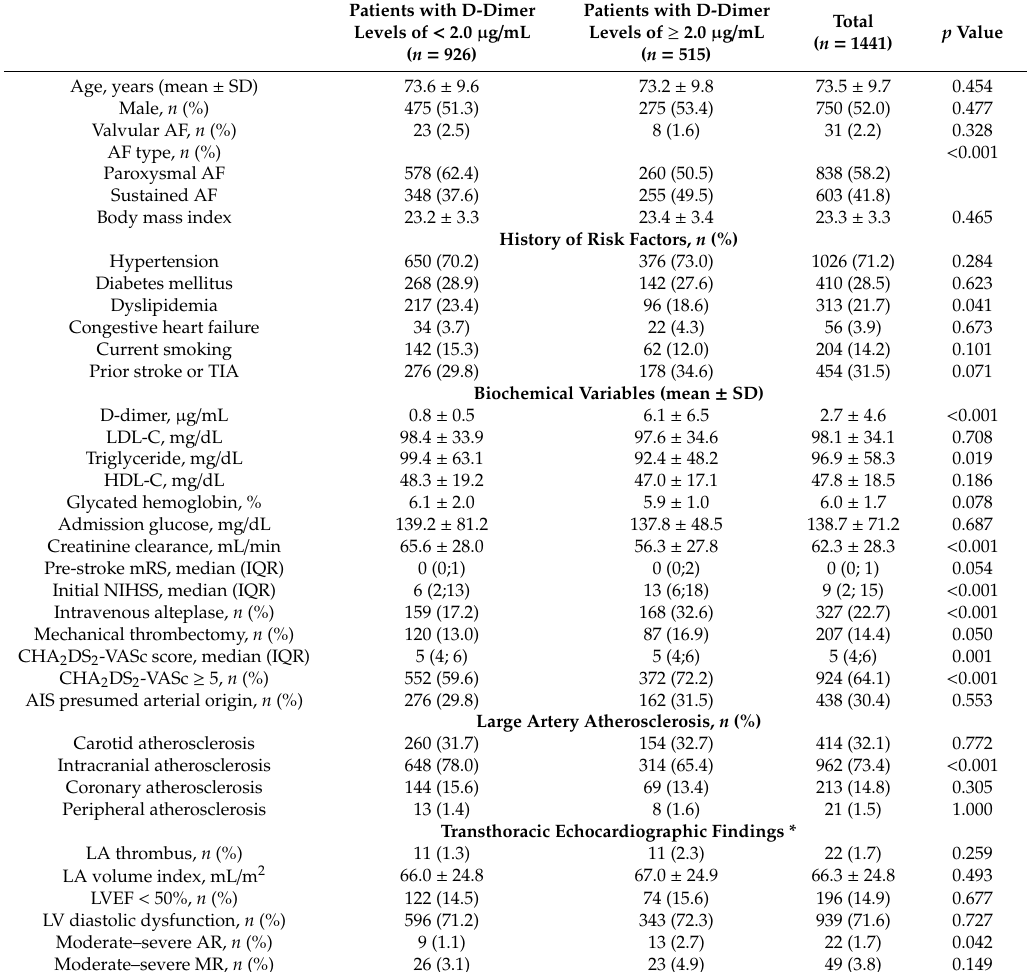
Table 1. Baseline clinical and biochemical characteristics according to the baseline D-dimer levels.